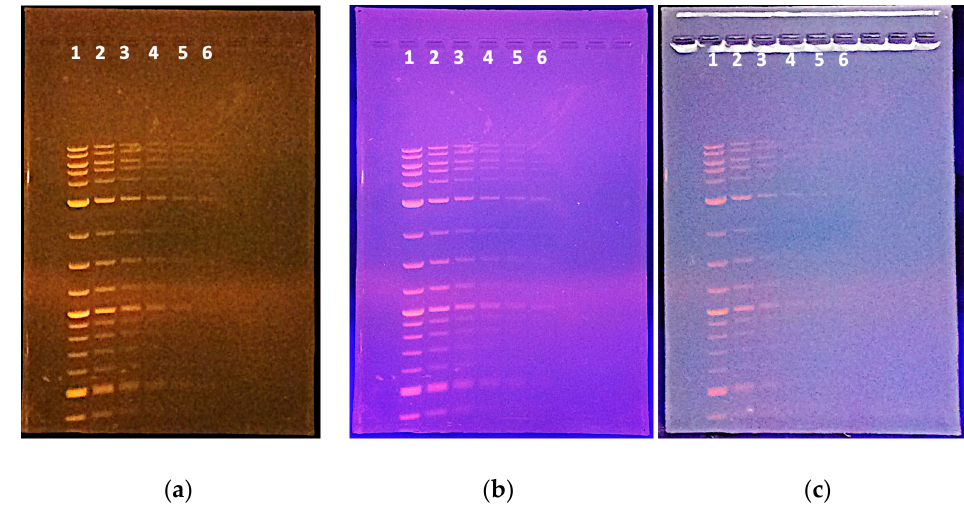
Figure 5. Sensitivity of documentation system using a 5 MP iPad Air camera. A 1:2 dilution series of a DNA molecular weight standard (NE Biolabs 1 kb plus ladder) was loaded on a 1% agarose/TAE gel, with 10 uL loaded per lane and six samples loaded. The amount of DNA in each lane is indicated in Table 1. The same gel was imaged under three conditions: ( a ) standard photo with UV illumination; ( b ) a photo without the 590 nm bandpass filter, and ( c ) a photo taken without using the UV-shielding hood—this is not advised due to the potential for eye damage; ( c ) demonstrates that the quality of image capture is much reduced without a light-shielding hood as fewer low abundance bands are visible. Table 1. Amount of DNA in each band (Figure 5). A dilution series was made using a DNA molec- ular weight marker (NE Biolabs 1 kb plus ladder) and the amount of DNA present in each band is listed below. Bolded rows indicate DNA at higher relative concentrations.